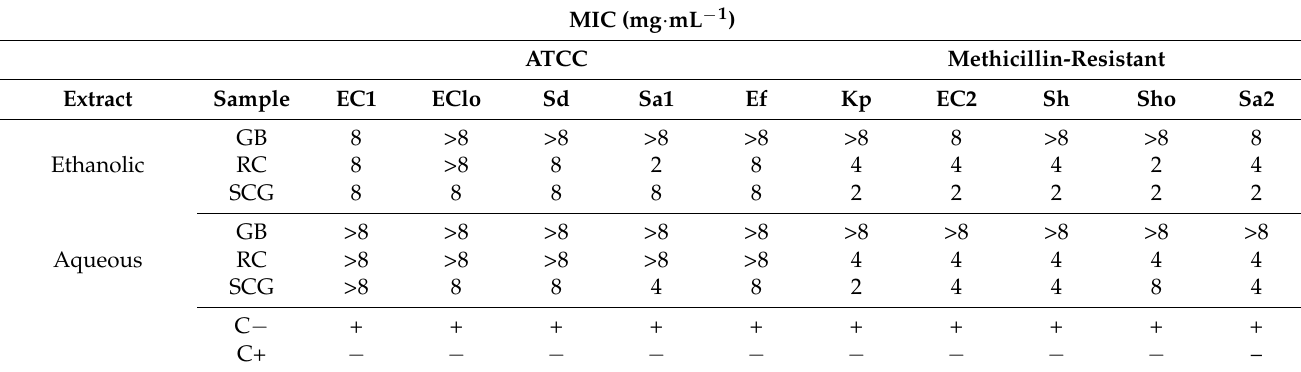
Table 2. Minimal inhibitory concentration (MIC) of coffee